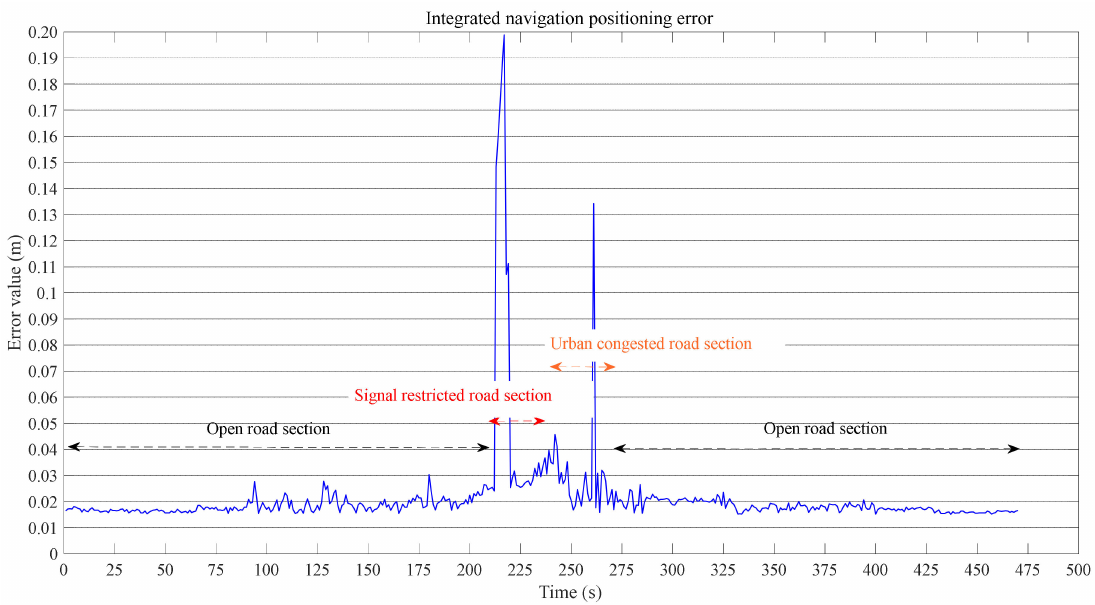
Figure 11. Integrated navigation positioning